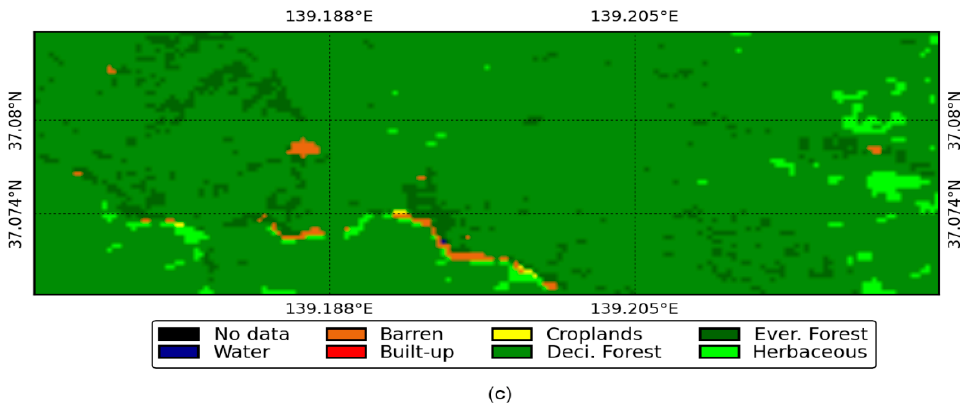
Figure 6. Performance of the JpLC-30 map over the JAXA High Resolution Land-Use and Land-Cover (JHR LULC) map: ( a ) Google Earth™ image; ( b ) JHR LULC map; ( c ) JpLC-30 map.